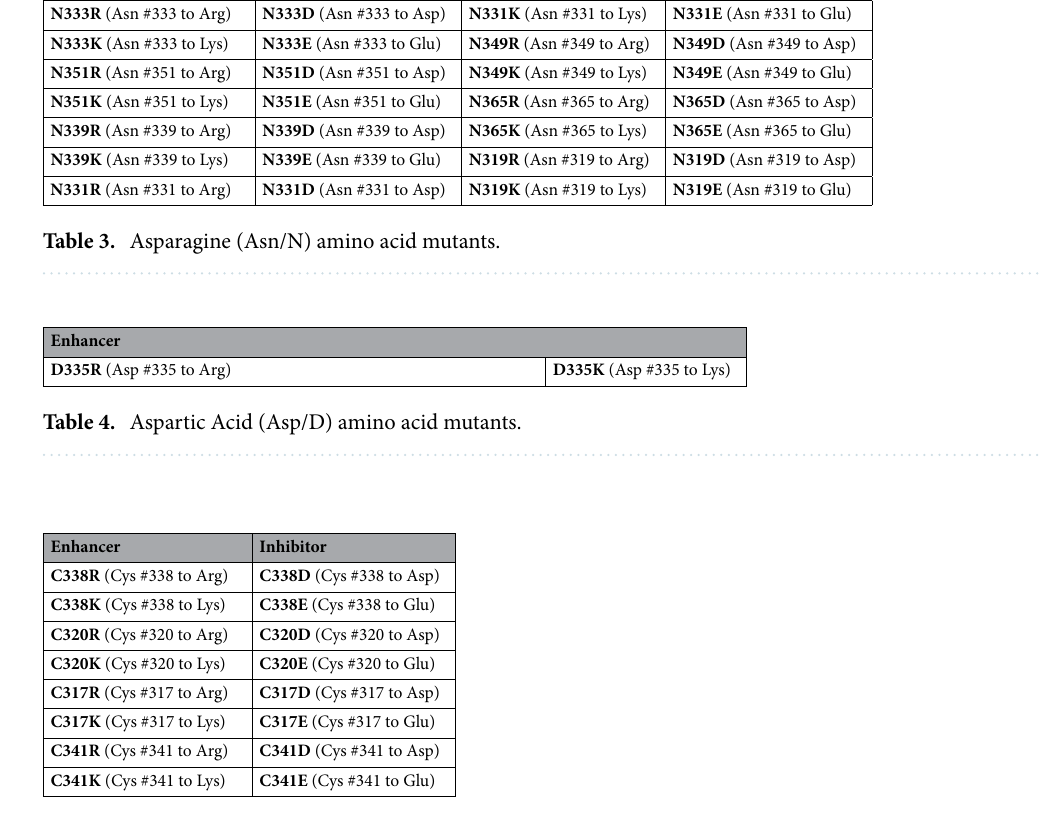
Table 5. Cysteine (Cys/C) amino acid mutants.